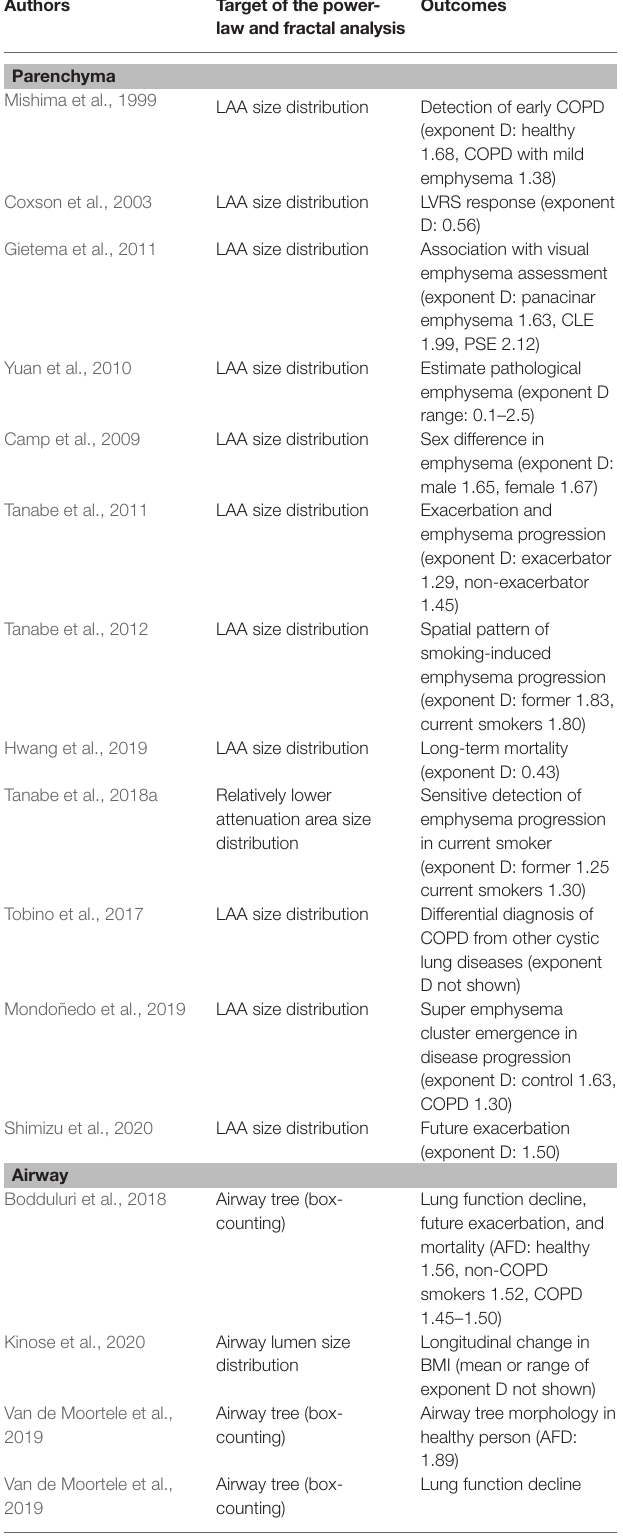
TABLE 1 | Summary of CT studies regarding the power-law and fractal analysis of lung structure and COPD outcomes.